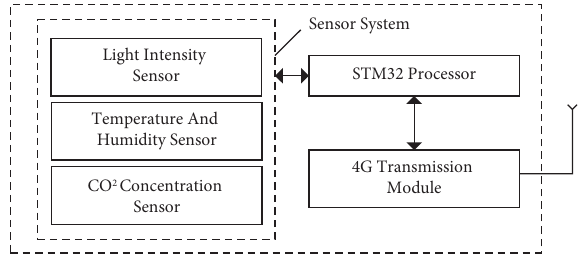
Figure 9: Block diagram of the environmental information col- lection